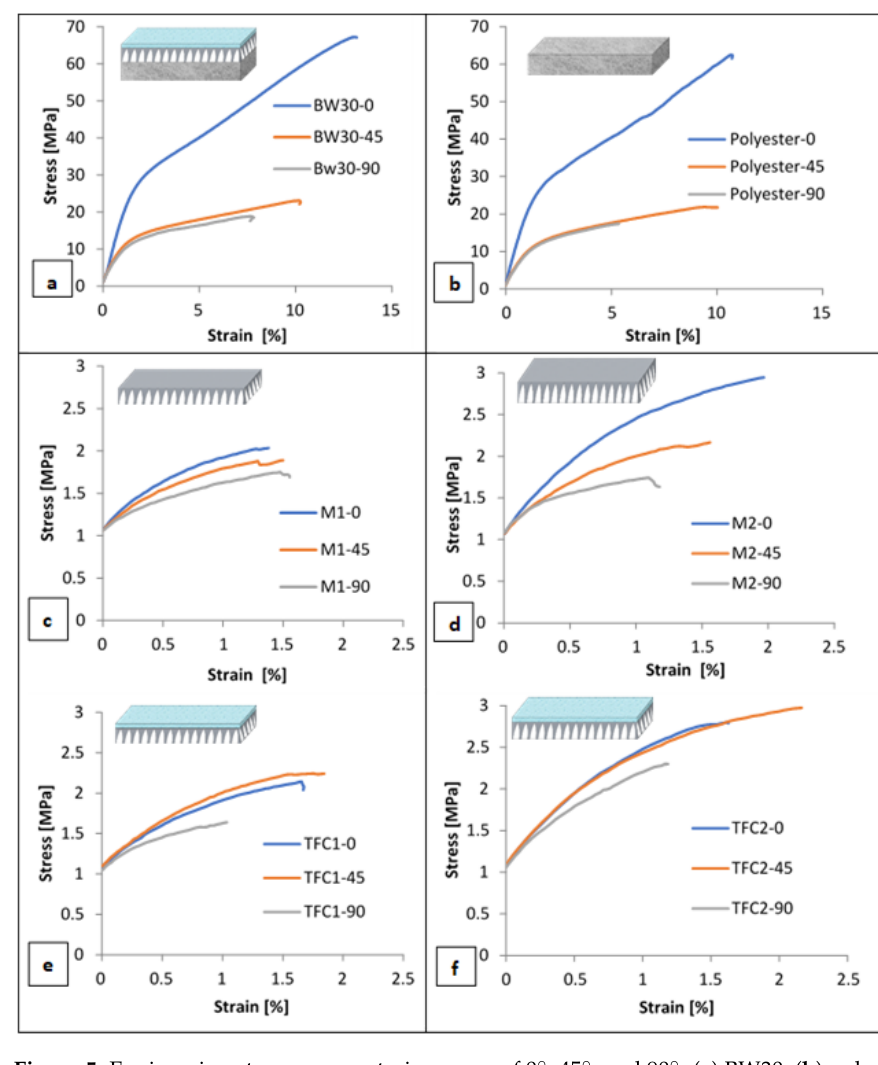
Figure 5. Engineering stress versus strain curves of 0 ◦ , 45 ◦ , and 90 ◦ : ( a ) BW30, ( b ) polyester, ( c ) M1, ( d ) M2, and ( e ) TFC1 and ( f ) TFC2 specimens.